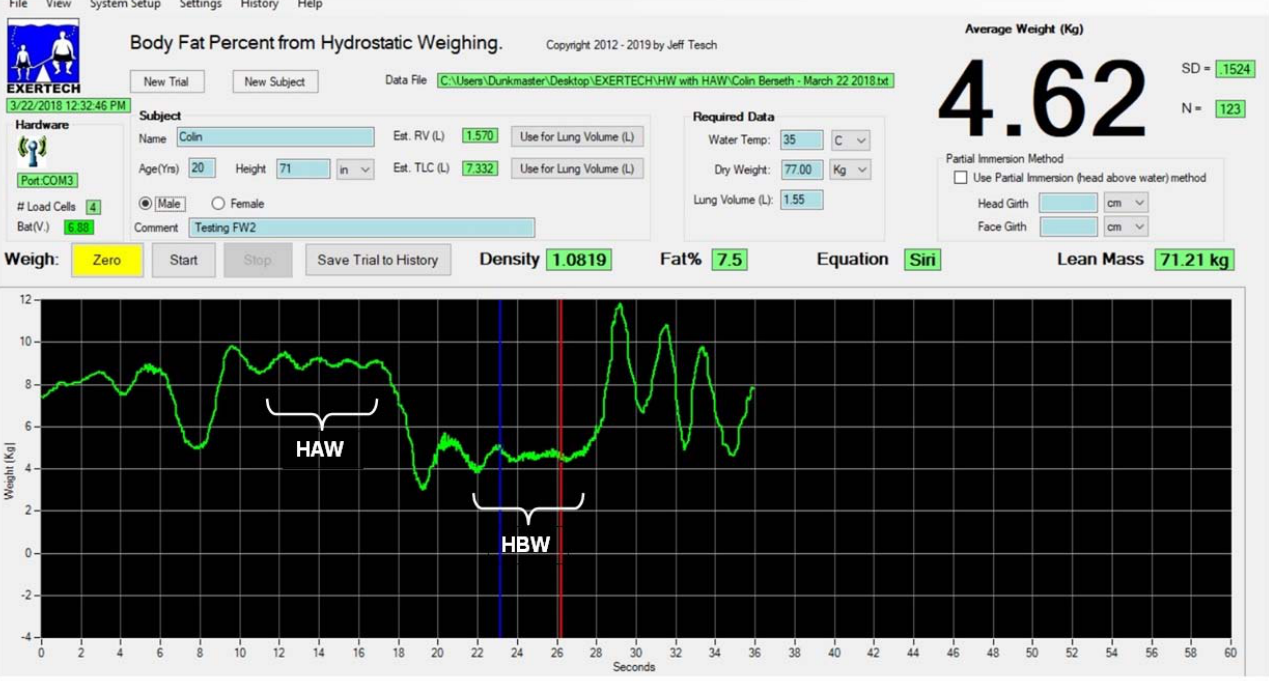
Figure 3. Screen capture of the weighing software showing head above water (HAW) and head below water (HBW) regions of a hydrostatic weighing trial.